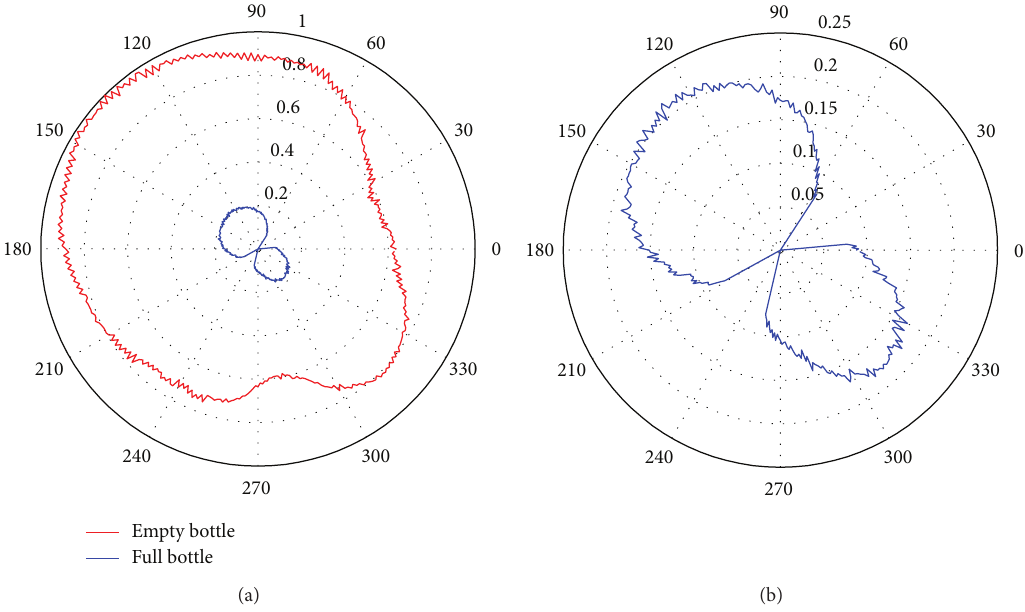
Figure 6: Percentage of received power, using tag 5, around bottle 2.